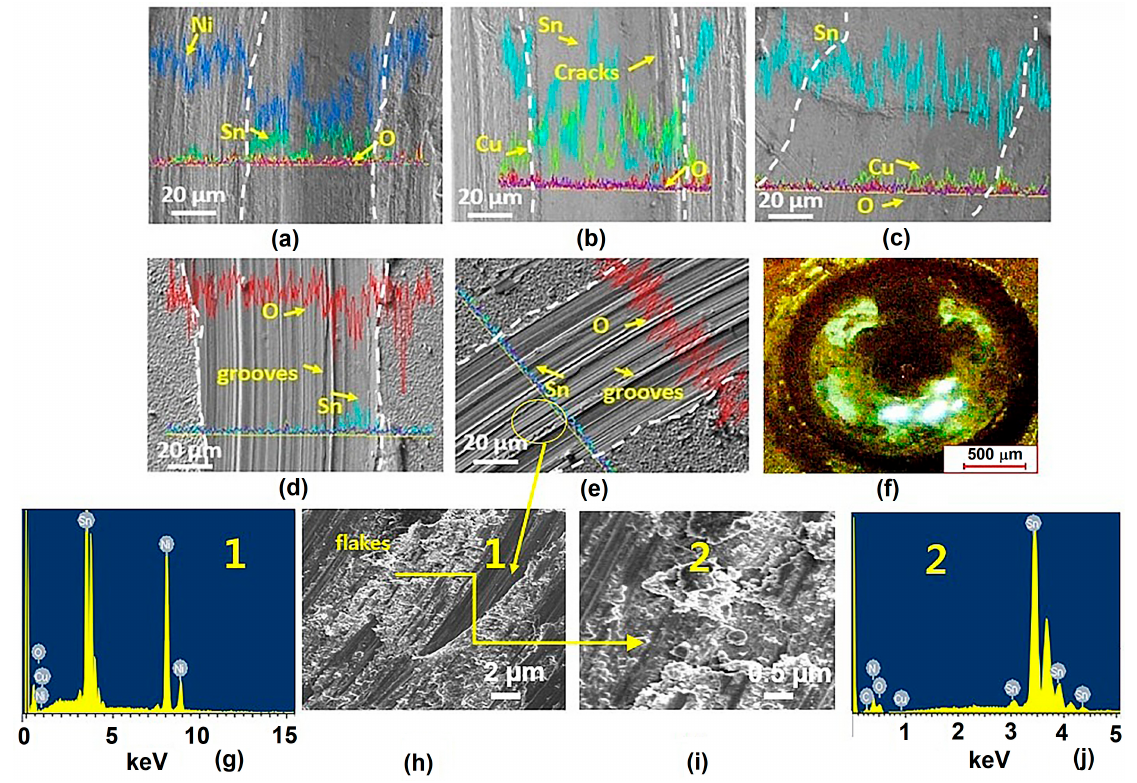
Figure 7. SEM morphology of wear tracks after 7 m sliding at various normal loads: ( a ) 2, ( b ) 4, ( c ) 6, ( d ) 8, and ( e ) 10 N. The corresponding line scans were observed across the wear tracks. The plated current density was 300 mA/cm 2 . The surface image of the ball indenter after wear is shown in ( f ). The image of the ball indenter was shown when the ball was used at a load of 10 N and the sample plated at 300 mA/cm 2 . ( g – j ) show the wear track EDS analysis of ( e ) at high resolution.